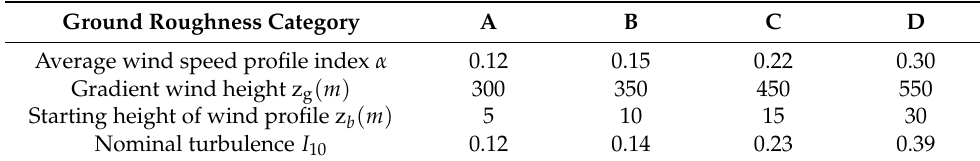
Table 1. Wind profile characteristics corresponding to different ground roughness categories. Ground Roughness